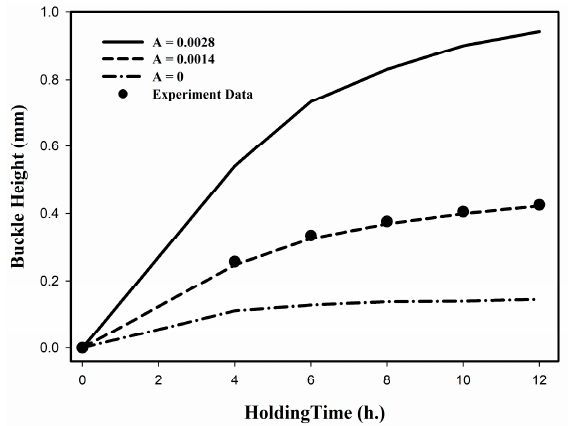
Figure 5. Buckle height of YSZ induced via CMAS infiltration at room temperature with different pre-factors and experiment data (the finite-element method is denoted by the spline line, and experimental method is denoted by the solid dot).